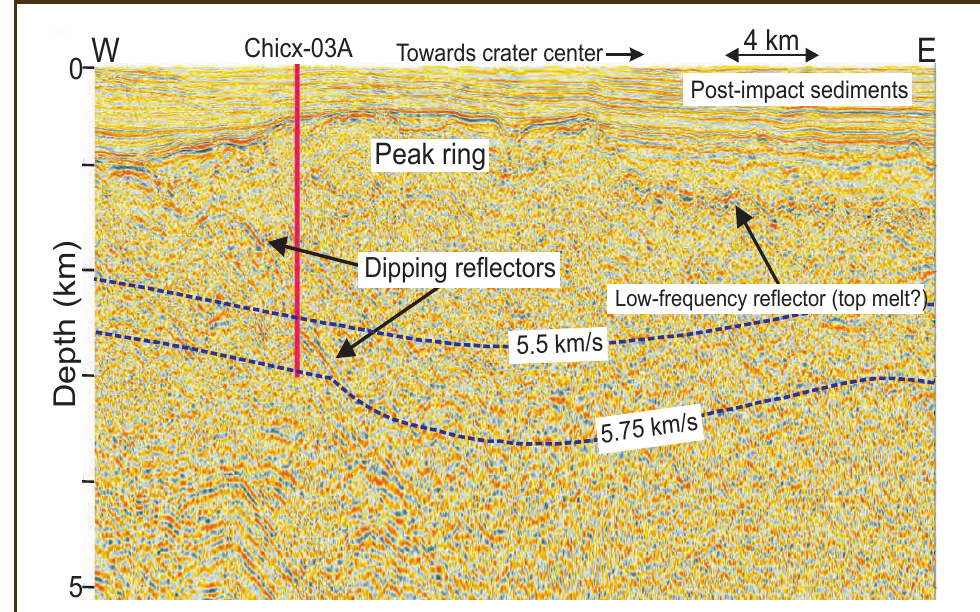
Figure 3. Newly acquired, depth-converted seismic profile Chicx-10. Thick red line shows proposed drill site Chicx-03A. The drill hole will sample ~700 m of post-impact sediments before penetrating the peak ring. A suite of dipping reflectors will be encountered at ~2.35 km depth. Dashed lines are velocity contours from our 3D tomographic velocity model. Vertical exaggeration is